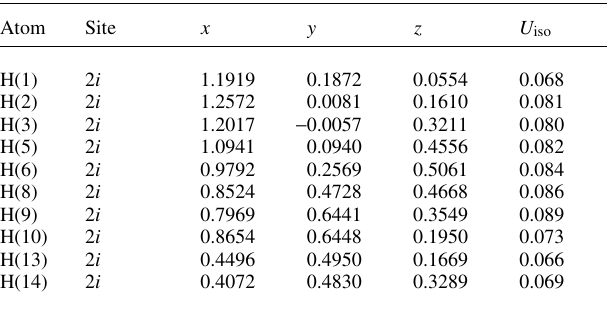
Table 2. Atomic coordinates and displacement parameters (in Å 2 )